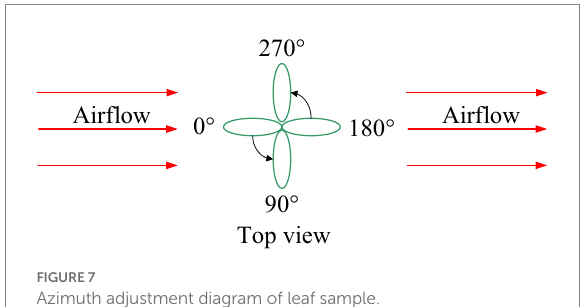
FIGURE 7 Azimuth adjustment diagram of leaf sample.